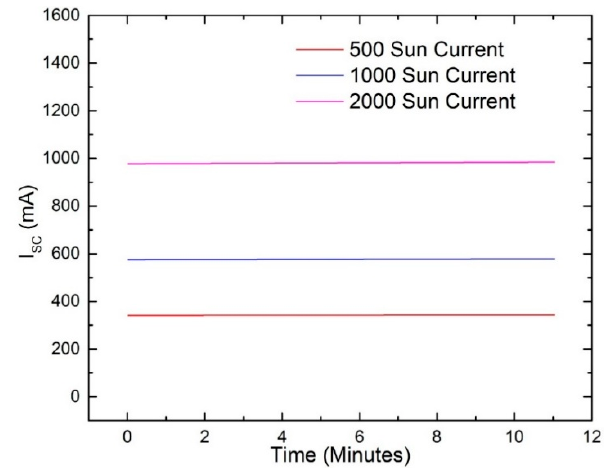
Figure 7. Short-circuit current as the function of time for the multi-junction solar cell under concentrated illumination corresponding to 500, 1000, 1500 and 2000 suns.